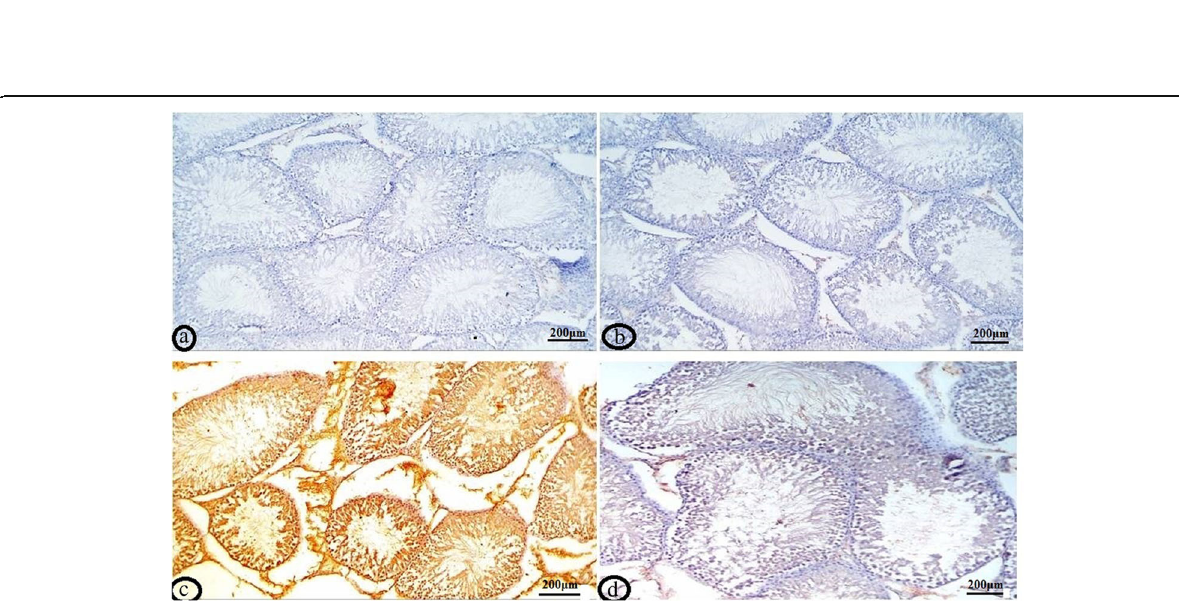
Fig. 8 Immunohistochemical staining of activated caspase-3 in rat testis. a Testis of control rats. b Testis of PSO-administered rats. c Testis of Al 2 O 3 -administrated rats. The intensity of activated caspase-3 immunostaining(brown color) is pre-dominant on spermatogonia and Leydig cells in Al 2 O 3 -administered group. d Testis of PSO+ Al 2 O 3 co-administered